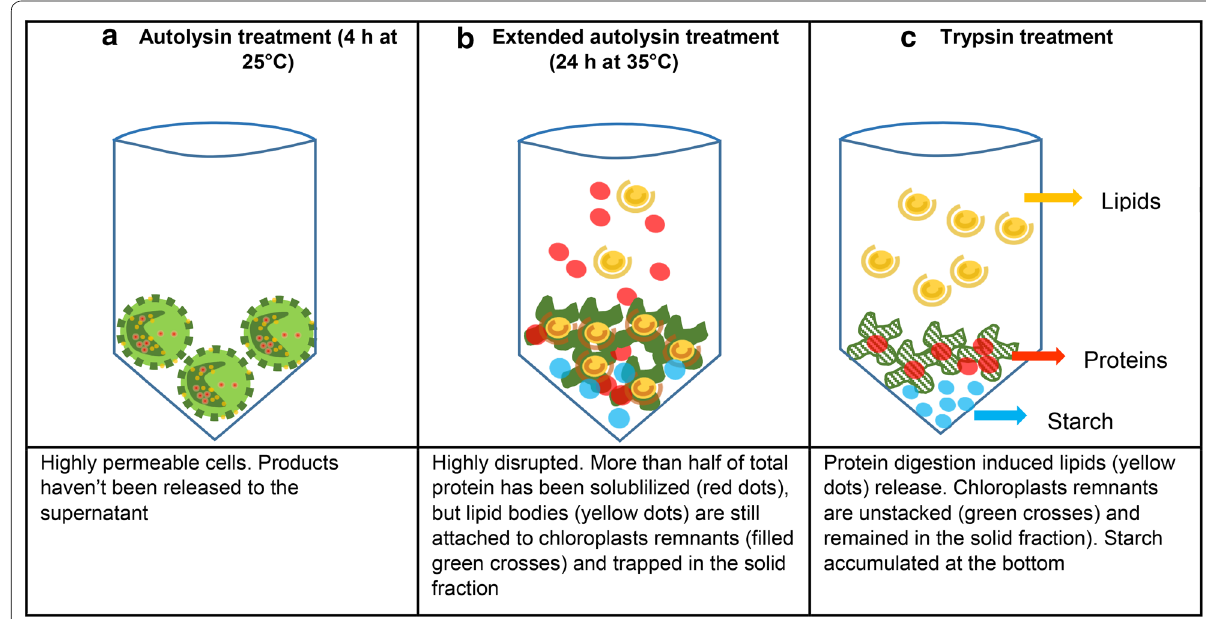
Fig. 9 Schematic representation of the enzymatic treatment with: a autolysin treatment for cell permeabilization, b release of cytosolic proteins, and c trypsin treatment for the release of lipid bodies and bioproducts